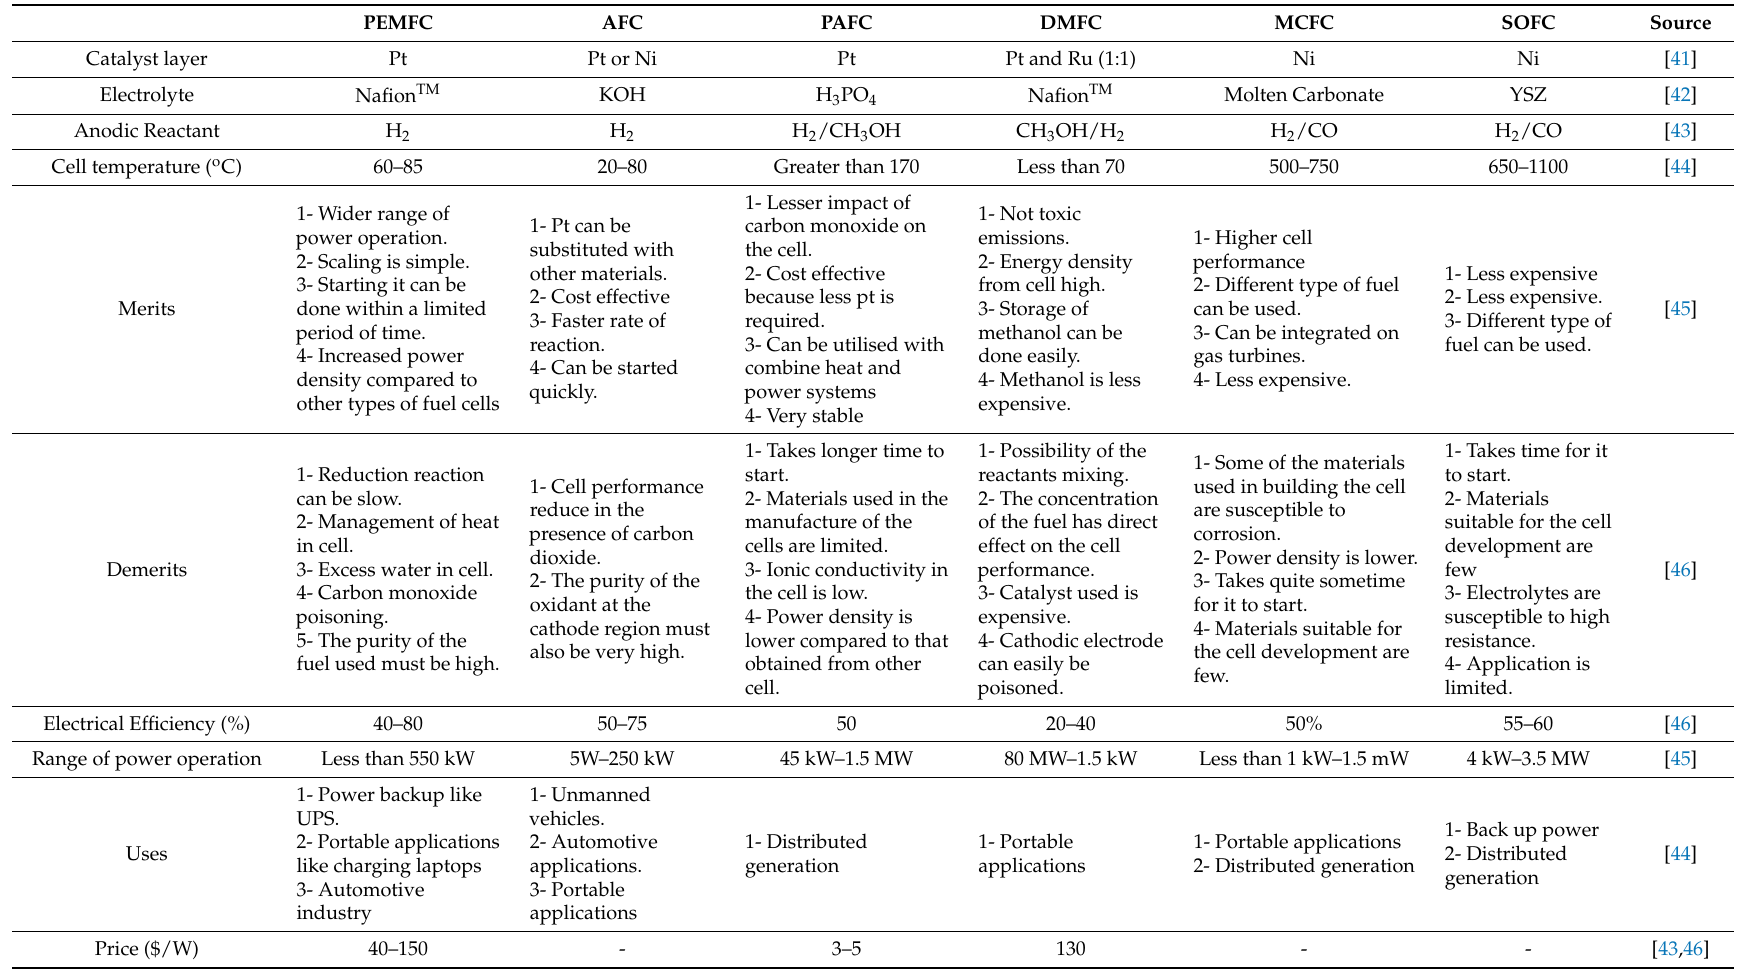
Table 1. Evaluating the characteristics of different types of fuel